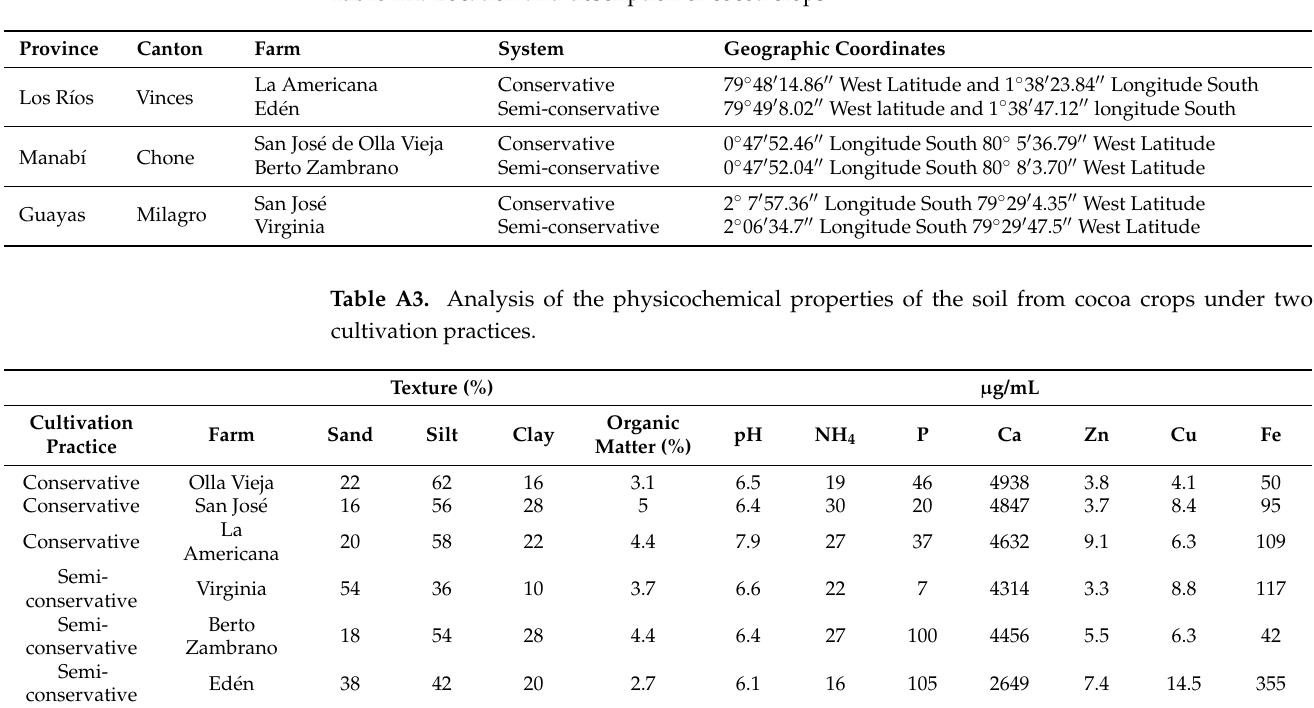
Table A2. Location and description of cocoa crops.